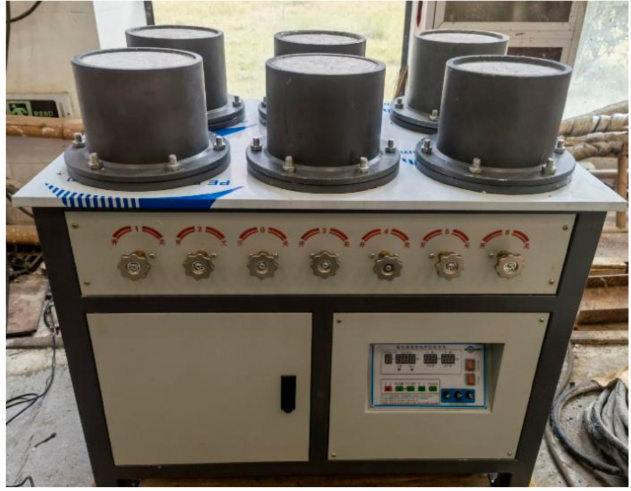
Figure 6. Impermeable loading